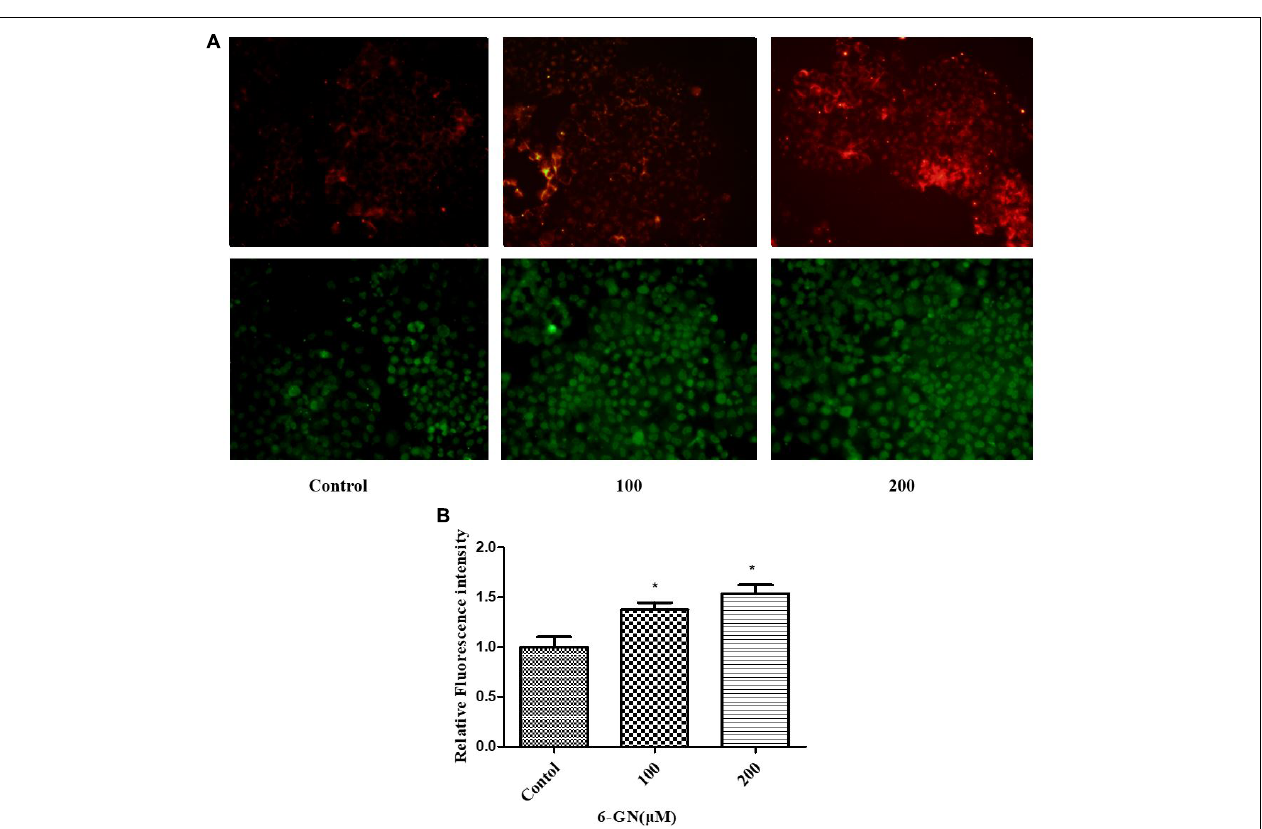
FIGURE 3 | LDL uptake and LDLR-binding assay. (A) The degree of LDL uptake and LDLR fluorescence intensity in HepG2 cells disposed with or without various concentrations of 6-GN for 24 h (200 × ). (B) Relative fluorescence intensity of LDLR disposed with or without various concentrations of 6-GN. Values were represented as mean + SD of three independent experiments. ∗ p < 0.05 versus